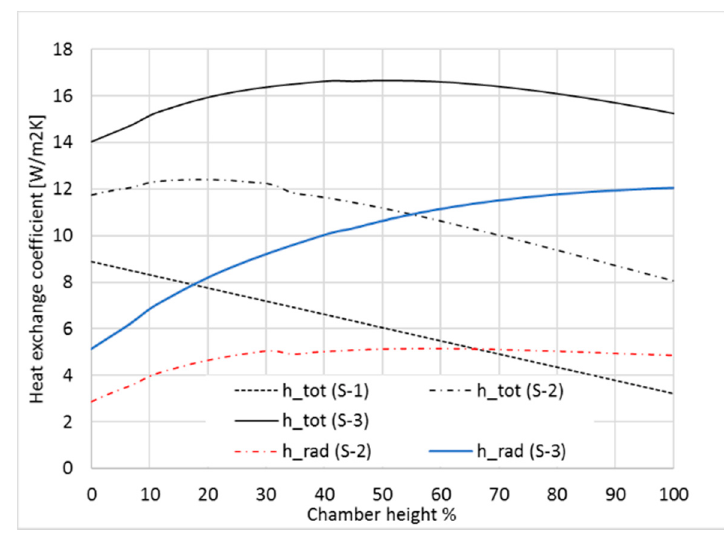
Figure 12. Total and radiant heat transfer coefficients for each Cold RC sub-section.